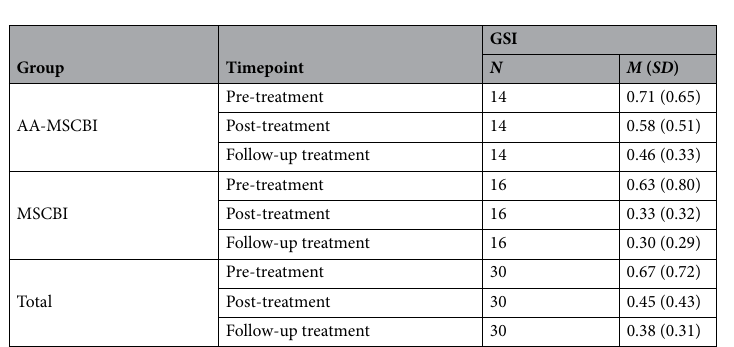
Table 2. General psychological distress. AA-MSCBI animal-assisted psychotherapeutic mindfulness- and self- compassion-based group intervention, MSCBI standard psychotherapeutic mindfulness- and self-compassion- based group intervention, GSI Global Severity Index of the Brief Symptom Inventory reflecting patients’ general psychological distress, N number of patients, M mean, SD standard